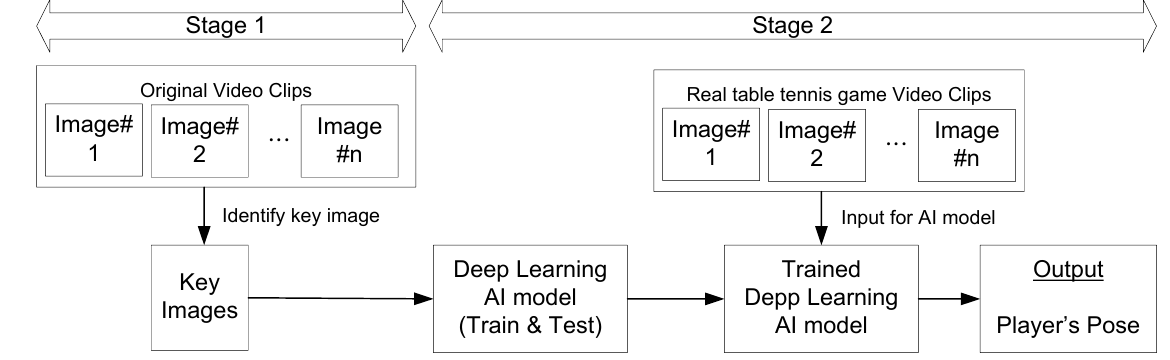
Figure 18. Two-stage AI pose recognition process.